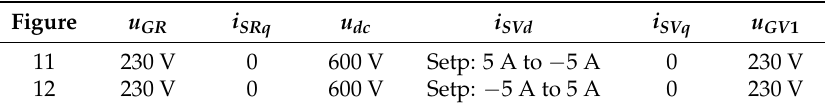
Table 8. Backward Euler stabilized controller compared with existing control methods.